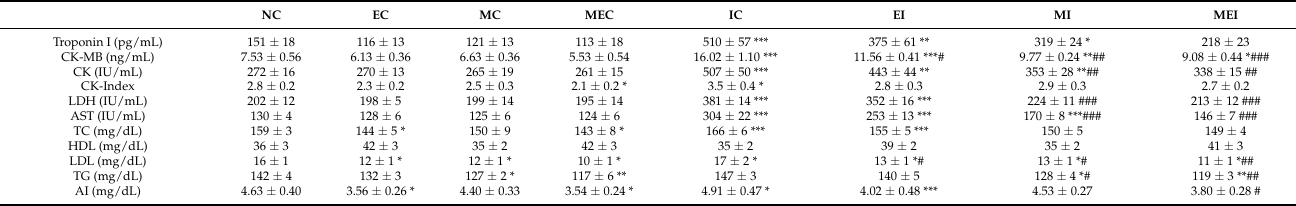
Table 3. Effect of exercise and melatonin supplementation on serum biochemistry in rats with or without isoproterenol